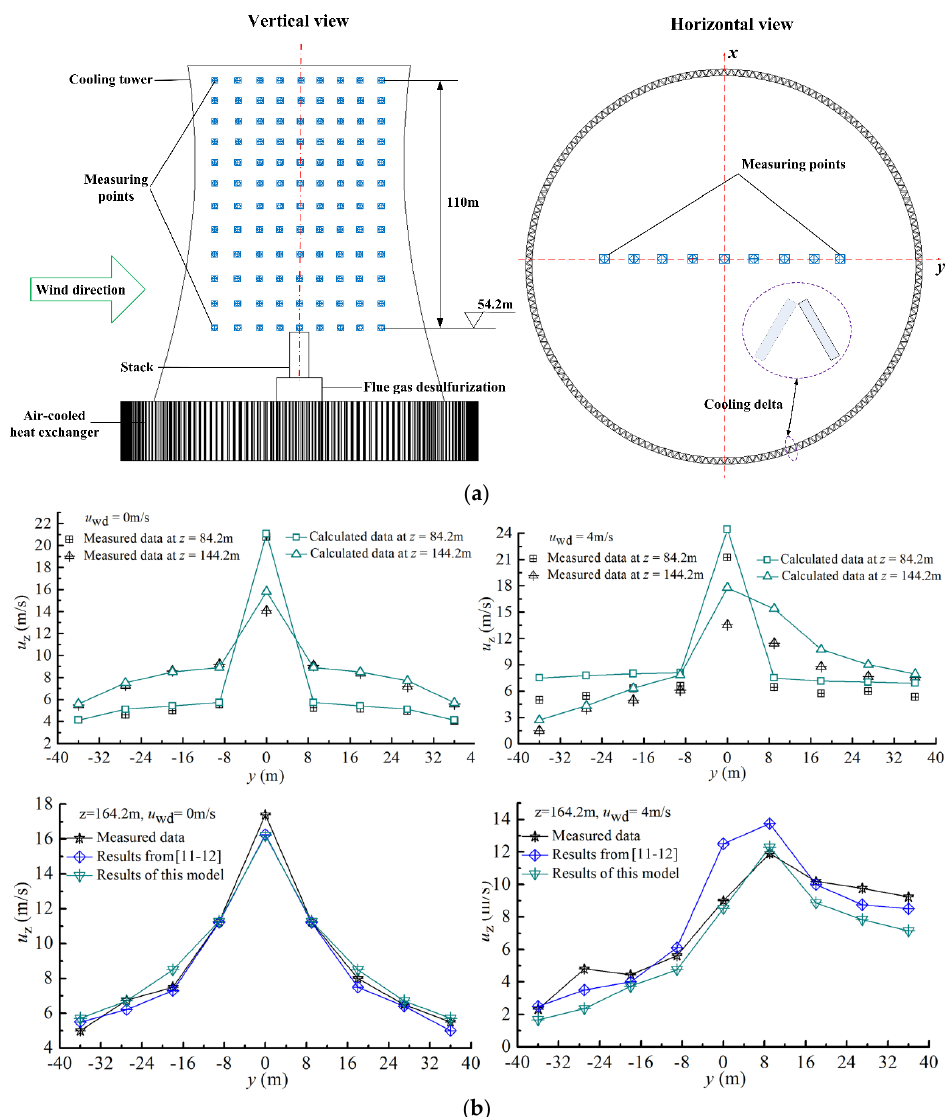
Figure 4. Comparisons of experimental and numerical ascending air velocities inside cooling tower. ( a ) Measuring points; ( b ) comparisons.